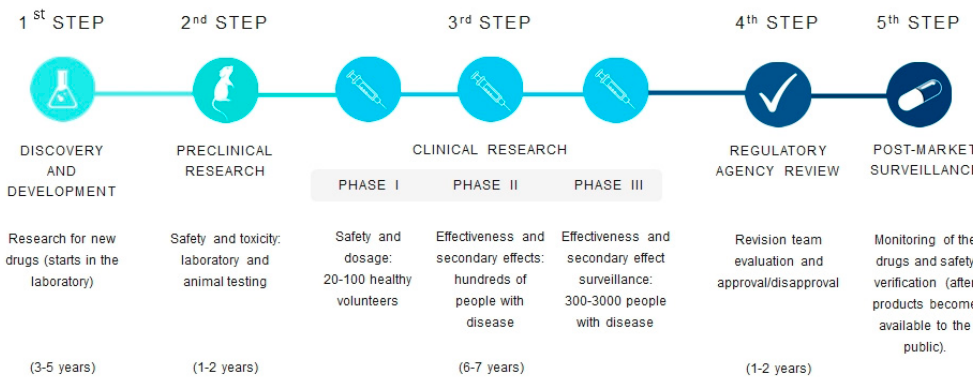
Figure 2. Drug discovery and development pipeline.